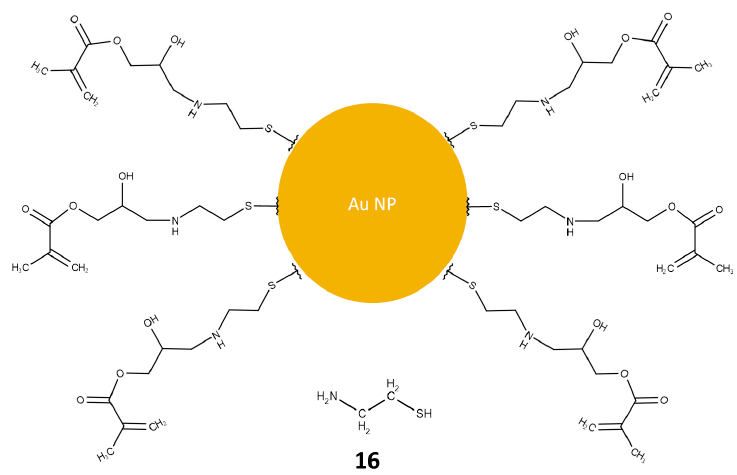
Figure 6. Chemical structure of cysteamine ( 16 ) crosslinked with glycidyl methacrylate and Au